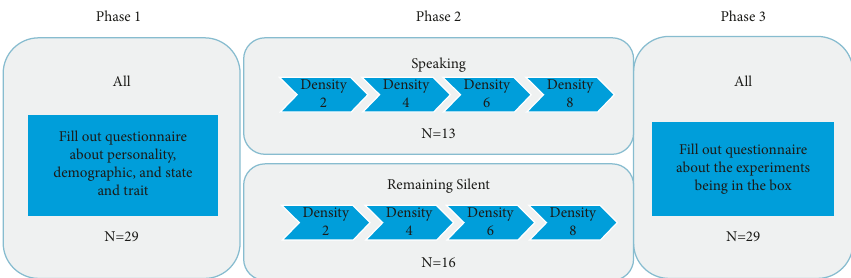
Figure 2: The figure shows the procedure of the experiment. While phases 1 and 3 were carried out by all participants, phase 2 shows the split into the two conditions. Nevertheless, the procedure in the condition is the same, too.